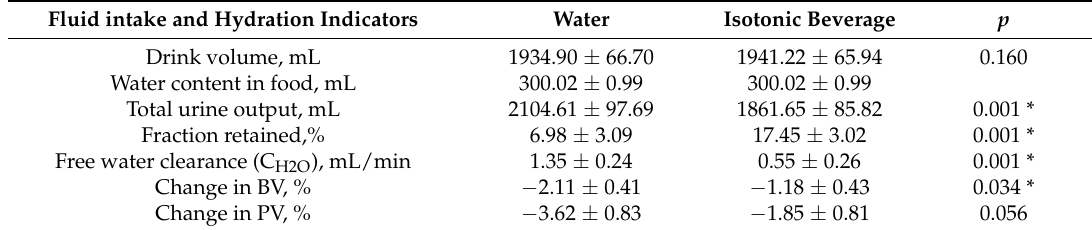
Table 4. Effects of distilled water and isotonic beverage on urine volume and blood volume (BV) and plasma volume (PV)